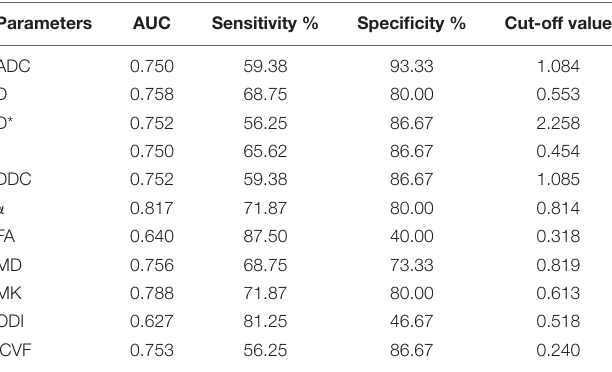
TABLE 2 | ROC results of dMRI-derived parameter in differentiating IDH1 genotype in